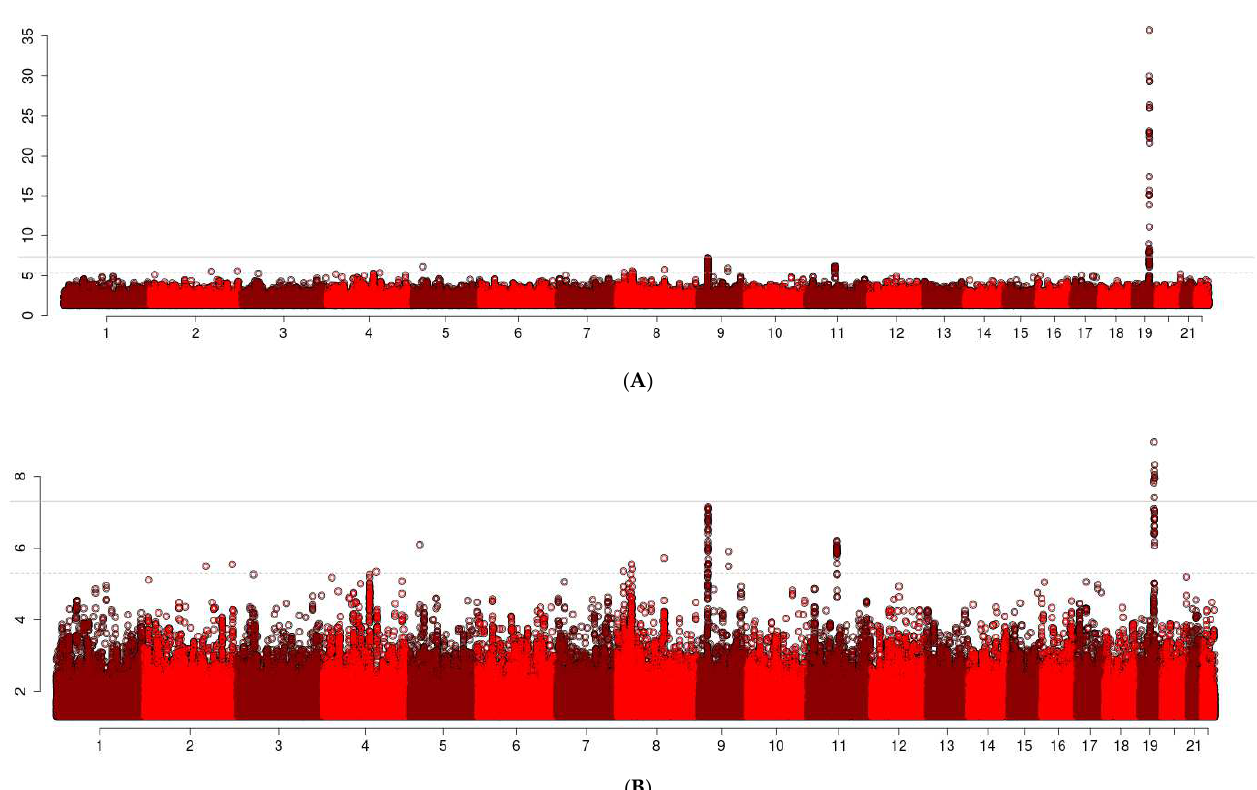
Figure 2. Manhattan Plot of the Discovery GWAS. The x -axis reports chromosomes and coordinates within chromosomes. The y -axis reports the −log10 of p -values. Top Panel ( A ) shows the unscaled Manhattan plot. Bottom Panel ( B ) shows the truncated version, where the y -axis shows only up to 10 (i.e., p -value of 10 −10 ).